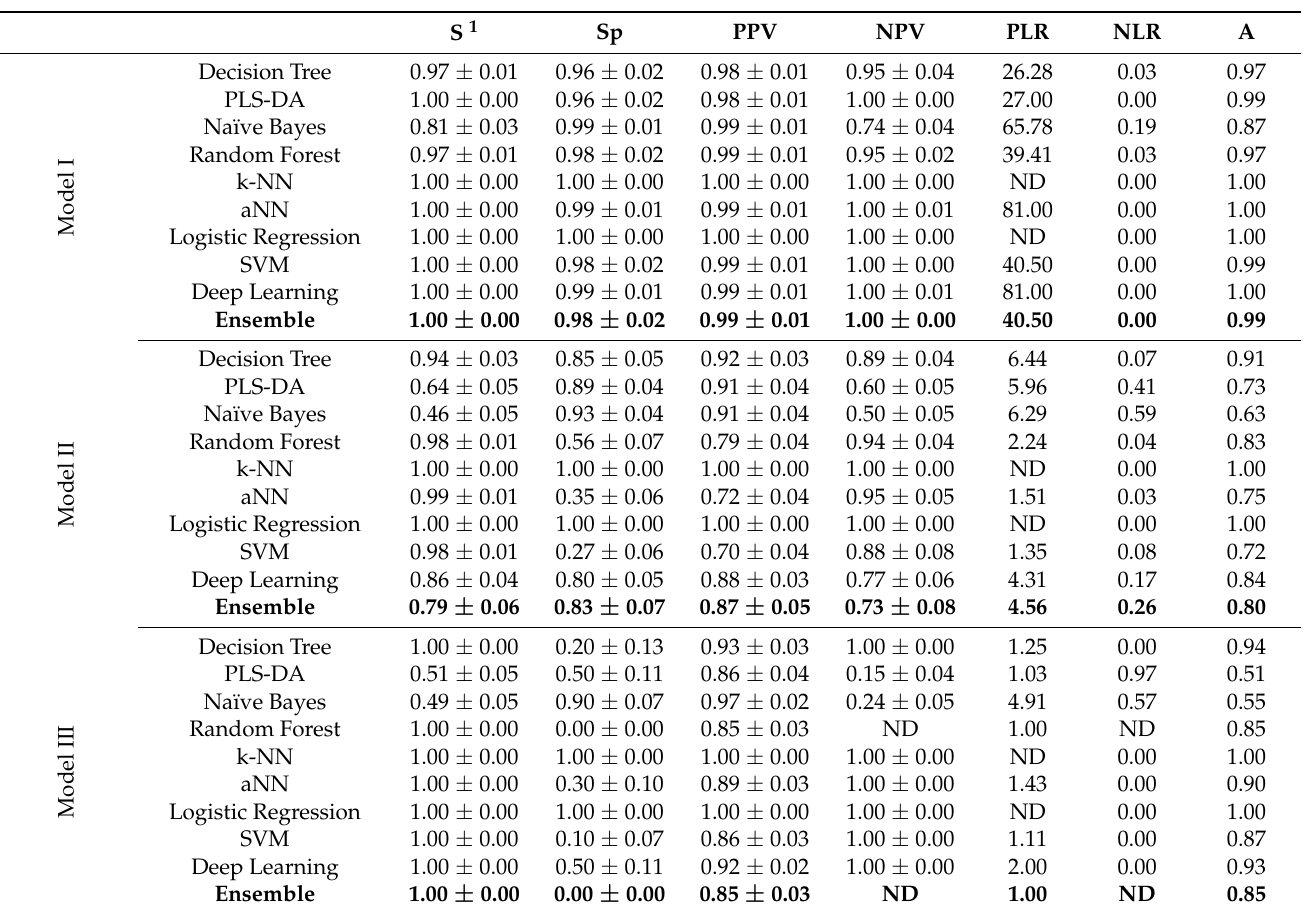
Table 2. Diagnostic performance: Presence of Bladder Cancer (Model I), Grading (Low-grade vs. High-grade) (Model II) and muscle invasivity (non-muscle invasive vs. muscle invasive) (Model III) of each classification model and the respec- tive